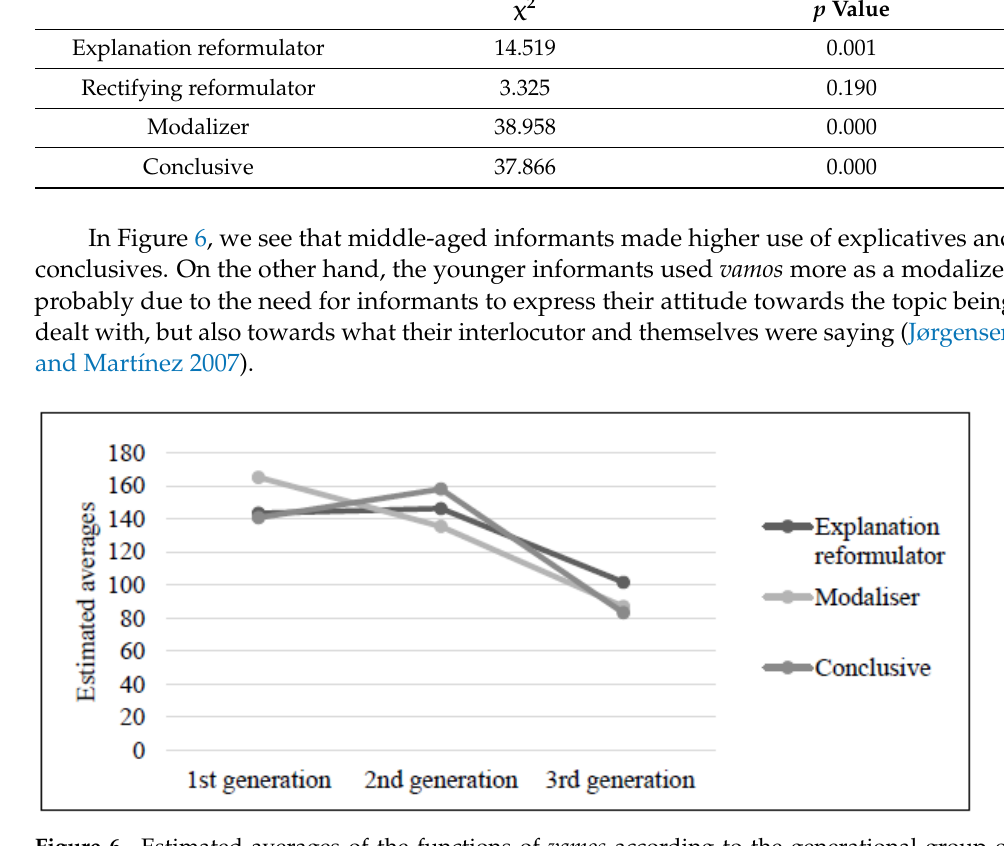
Table 5. Data from the Kruskal–Wallis ANOVA test on the functions of vamos and the education variable.